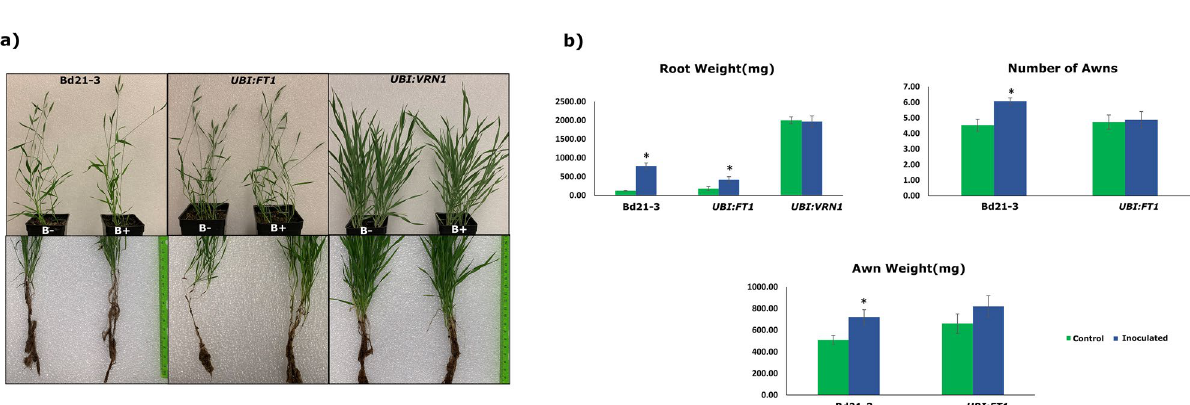
Figure 2. A comparison of relative transcript abundance of flowering genes ( FT1, FT2, VRN1 and VRN2 ) in shoots of control and inoculated ( a ) Bd21-3 (rapid flowering line) and ( b ) Bd30-1(intermediate flowering line) at 14 and 28dpi. Numbers above the box plot represent fold change. * indicates significance according to Independent Student t-test ( p < 0.05).